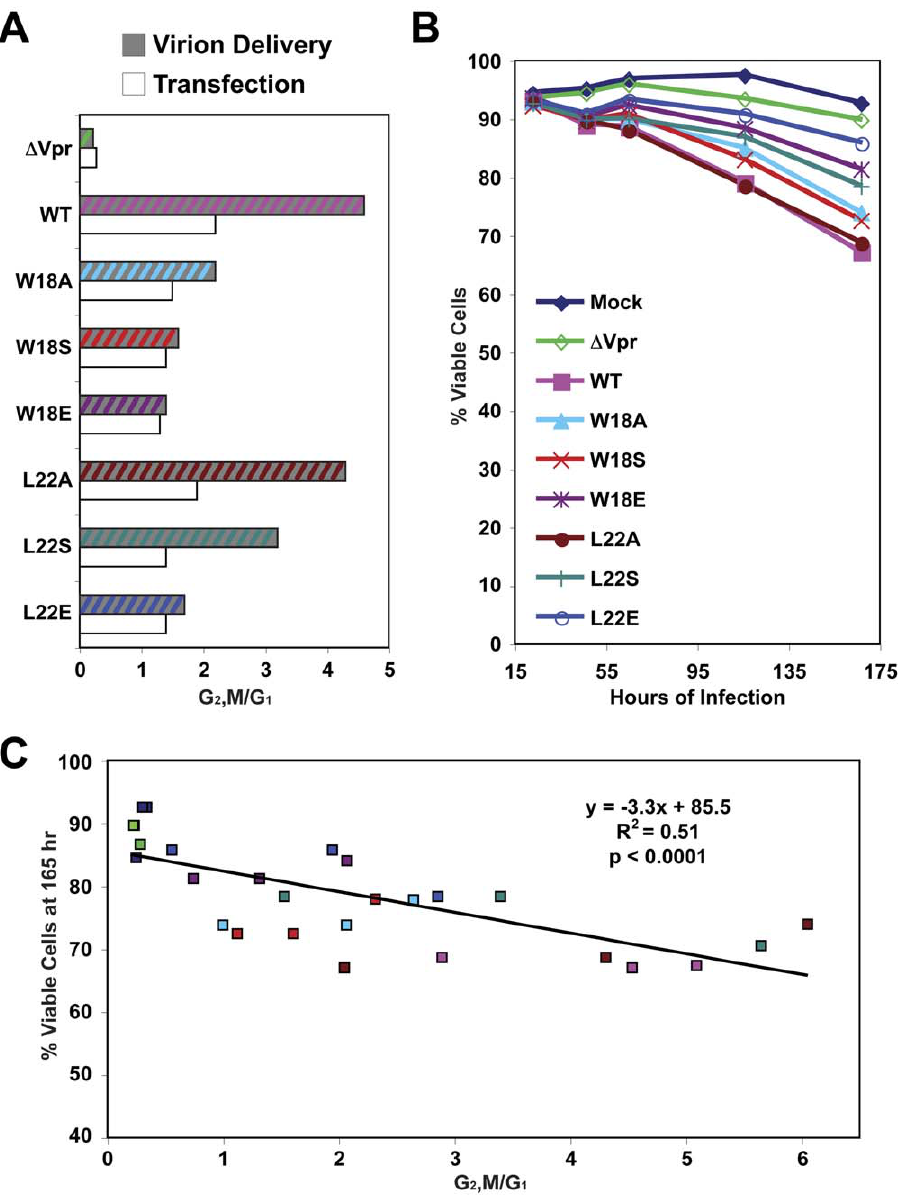
Figure 5. Vpr G2/M arrest correlates with cell death induced by virion delivery. ( A ) WT or mutant Vpr proteins (denoted by the single letter amino acid changes) were delivered (Vpr v ) into Jurkat cells, and separately Jurkat cells were co-transfected with pcDNA3-hVpr plasmids expressing WT or mutant Vpr (or the empty vector control) and pEGFP-N1 as a transfection marker at a ratio of 5:1. Infected and transfected cells were analyzed for DNA content of the PI-stained cells by flow cytometry. G1 and G2/M populations were modeled using the Watson Pragmatic cell cycle model, and the G2,M/G1 ratios were plotted on the x-axis. ( B ) The viability of the Vpr v -treated cells was monitored over time by flow cytometry (detection of PI-negative, forward-scatter high events), and the percentage of viable cells is plotted over time. These data are representative of three experiments. ( C ) The G2,M/G1 ratios and viability of Vpr v -treated cells at 165 hour post-infection from three independent experiments were plotted. Each measurement is color-coded as in (B). Spearman’s rank test was used to determine the